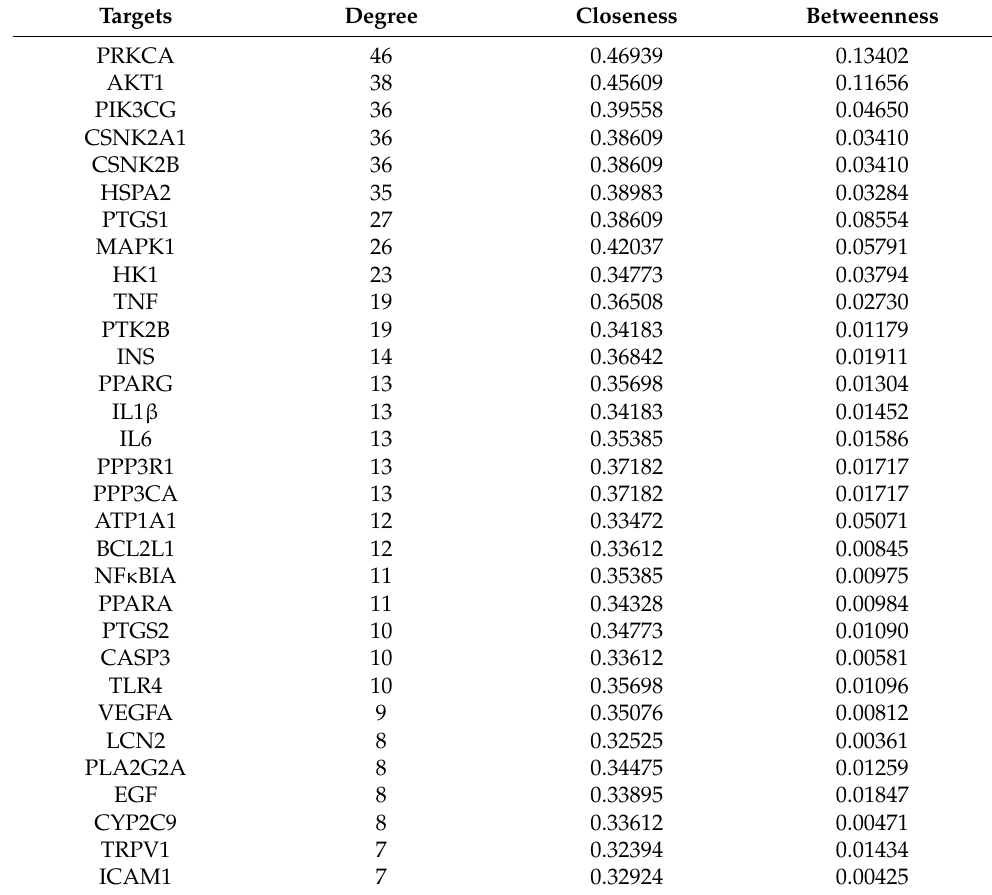
Table 1. The key targets screened from the network